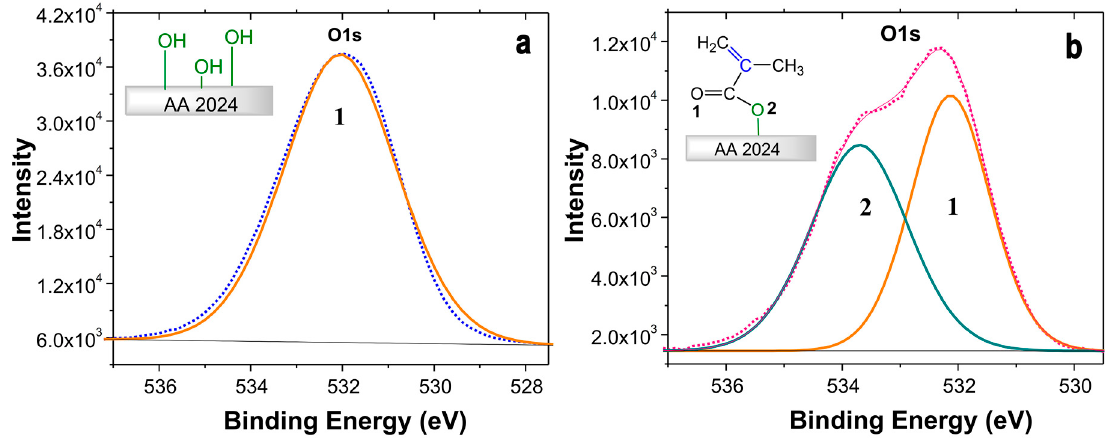
Figure 2. XPS spectra showing the O1s peaks on the aluminum alloy: ( a ) chemically etched (AA); ( b ) chemically etched and pseudotransesterification treated (AA-TE).